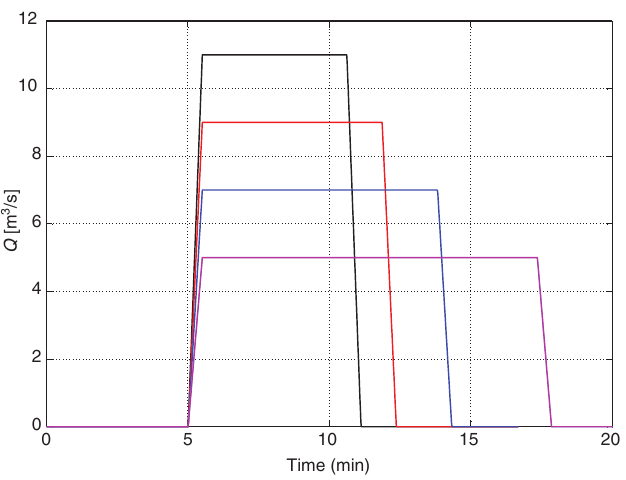
Figure 7. Cuinchy Lock Operations for Different Discharge Schedules. With Black, an Operation with Maximum of 11 m 3 /s Dis- charge, with Red 9 m 3 /s, with Blue 7 m 3 /s, and with Magenta 5 m 3